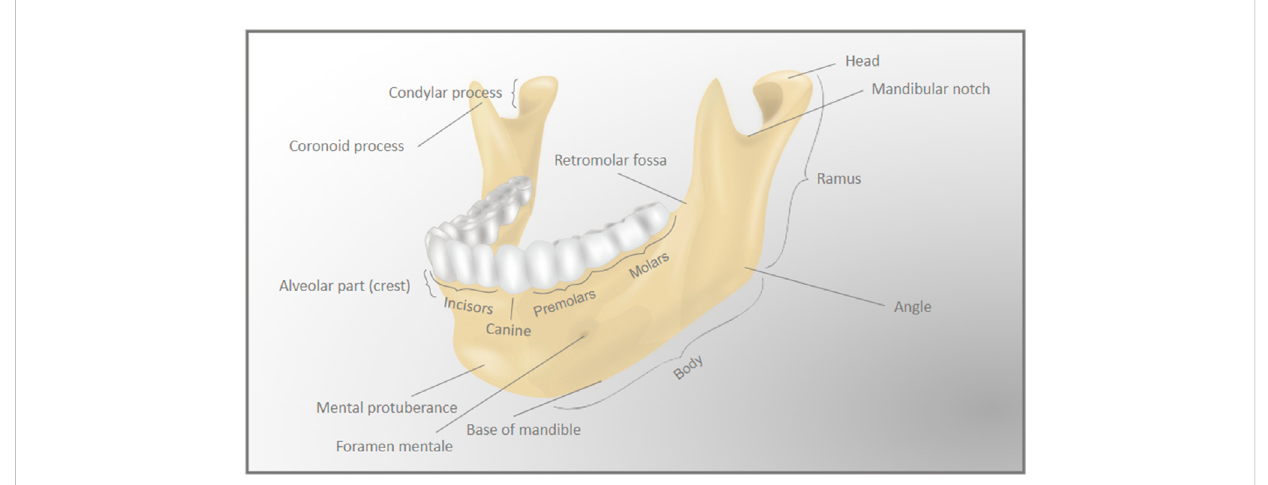
FIGURE 2 Detailed anatomy of the mandible. The complex anatomy of the mandible (lower jaw) bone is represented by the differently labeled anatomic regions.